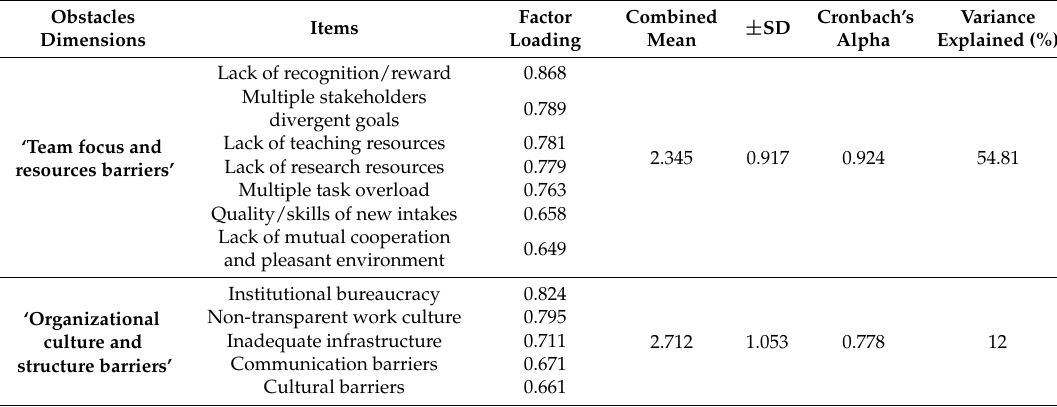
Table 4. Factor analysis—Obstacles to teaching and learning